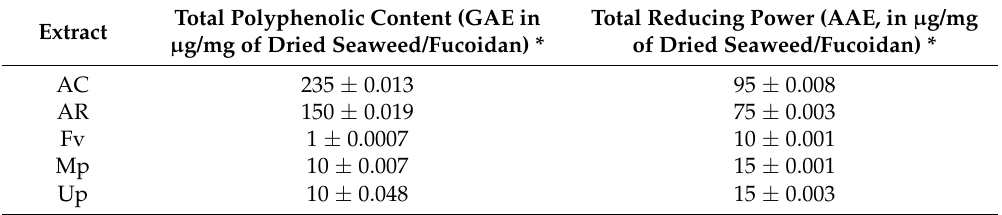
Table 1. Total polyphenolic content and reducing power of the S. incisifolium aqueous extracts, and the fucoidans from F. vesiculosus (Fv), M. pyrifera (Mp) and U. pinnatifida (Up).